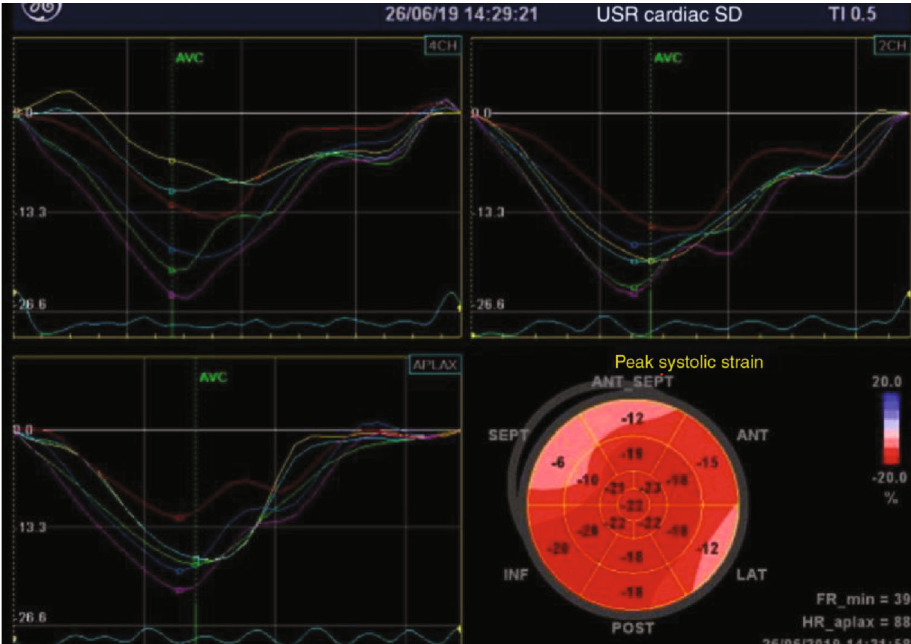
Figure 3: Peak longitudinal strain 3 days after myocardial infarction showing reduced strain in basal anteroseptolateral segments while inferior and posterior segment remained